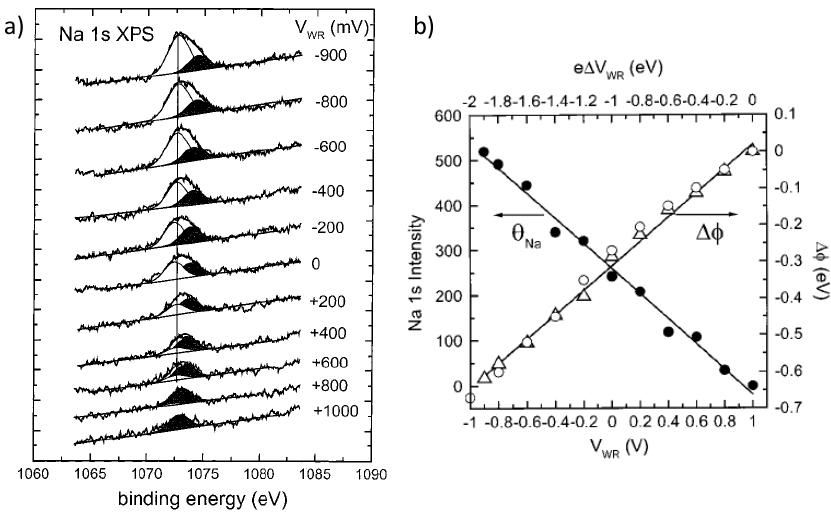
Figure 5. Na 1s XPS spectra taken on a Rh/Na- βAl 2 O 3 electrochemical catalyst (580 K, UHV conditions), showing the effect of catalyst potential ( V WR ) on sodium coverage ( a ). Invariant component due to Na on Rh; shifting component due to Na in solid electrolyte. Influence of V WR on the integrated Na 1s XPS intensity due to Na on the Rh surface and associated work function change of the catalyst film ( b ). Reprinted with permission from Ref. [41]. Copyright 2000 American Chemical Society.